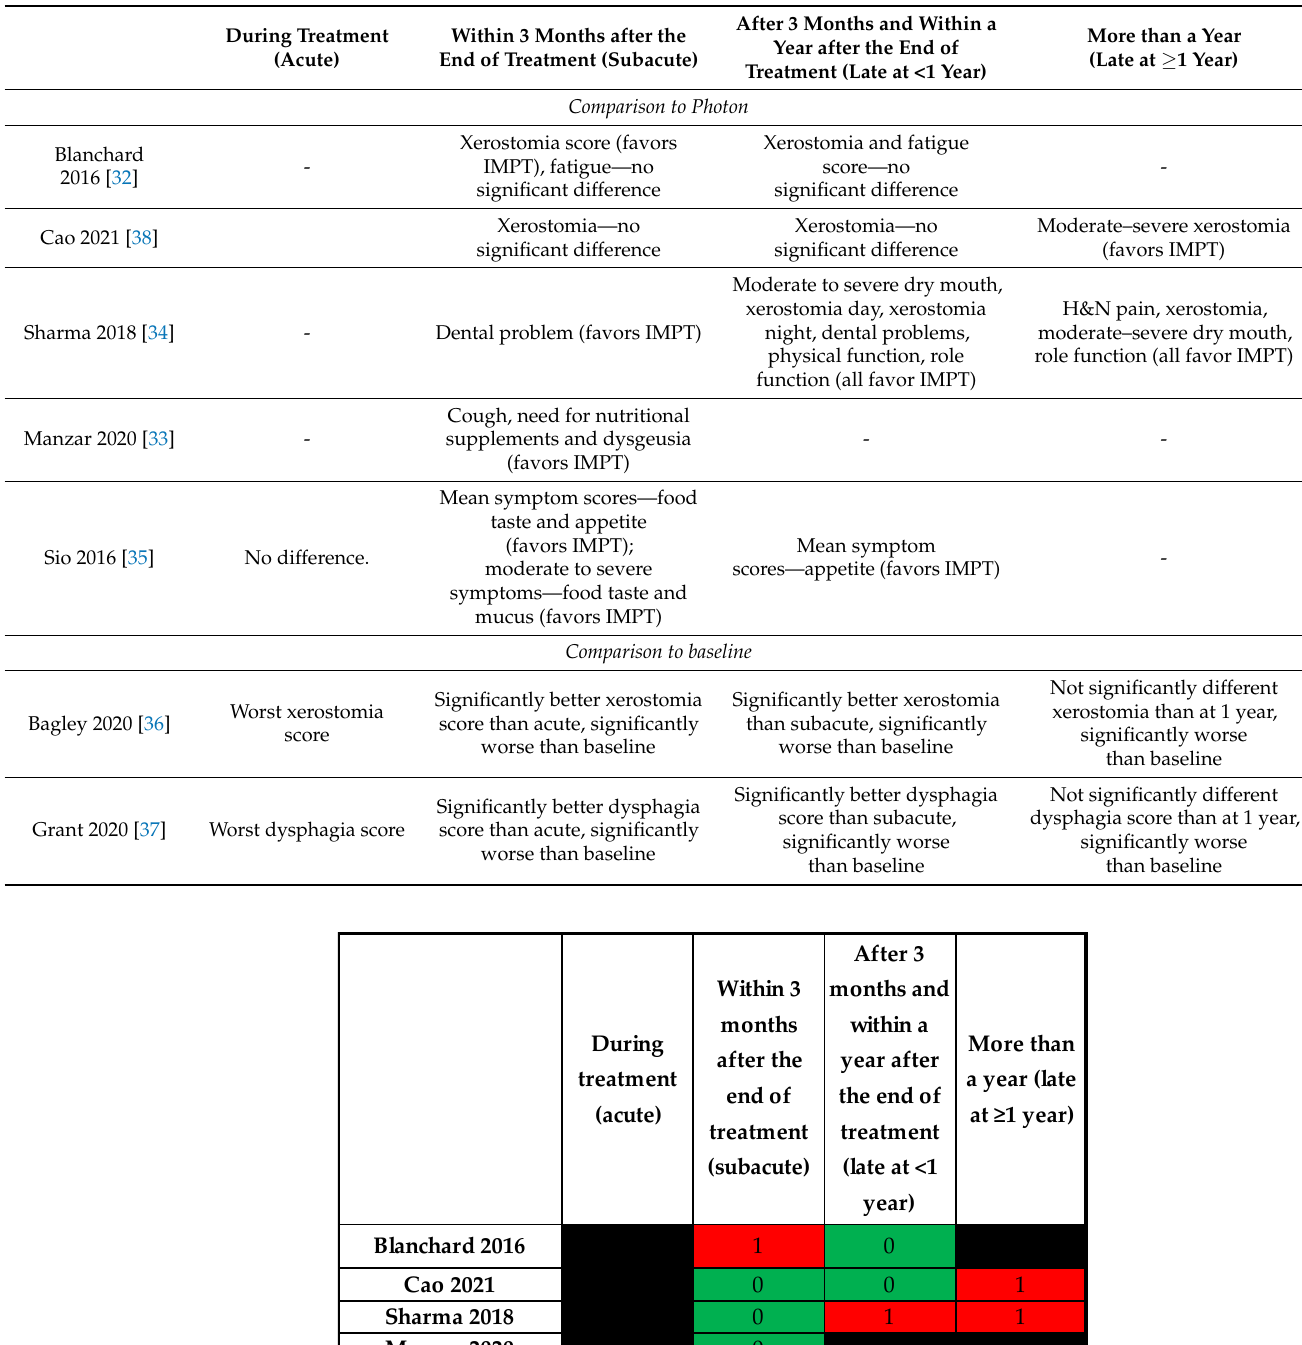
Table 4. Significant endpoints based on the time point divided into acute, subacute, late at <1 year, and late at ≥ 1 year.